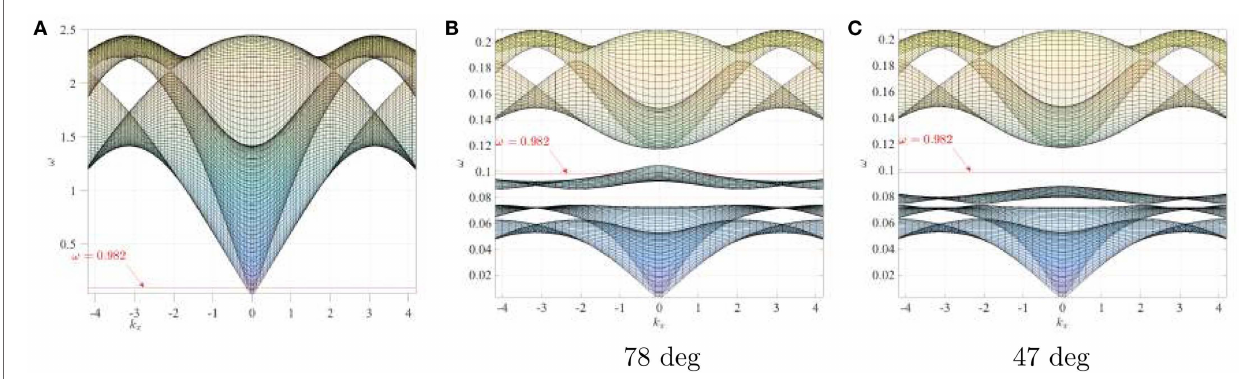
FIGURE 13 | Dispersion surfaces for a TL (panel (A) ) and for two TLRs (panels (B,C) ). Panel (A) has been obtained using the parameters listed in the third row of Table 2 . Panels (B,C) correspond to the parameters listed in the second and first rows of Table 2 , respectively.